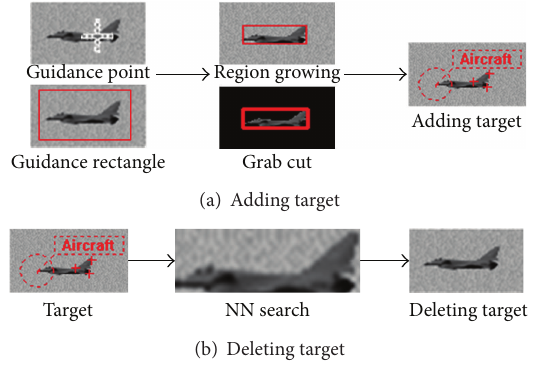
Figure 8: Guidance